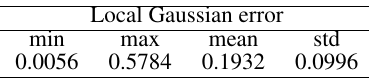
Figure 9. The variation of camera distortion correction with the local Gaussian error. The direction and the magnitude of the vectors represent the direction and the magnitude of the variation of camera distortion correction at the origin of the vector, respectively.